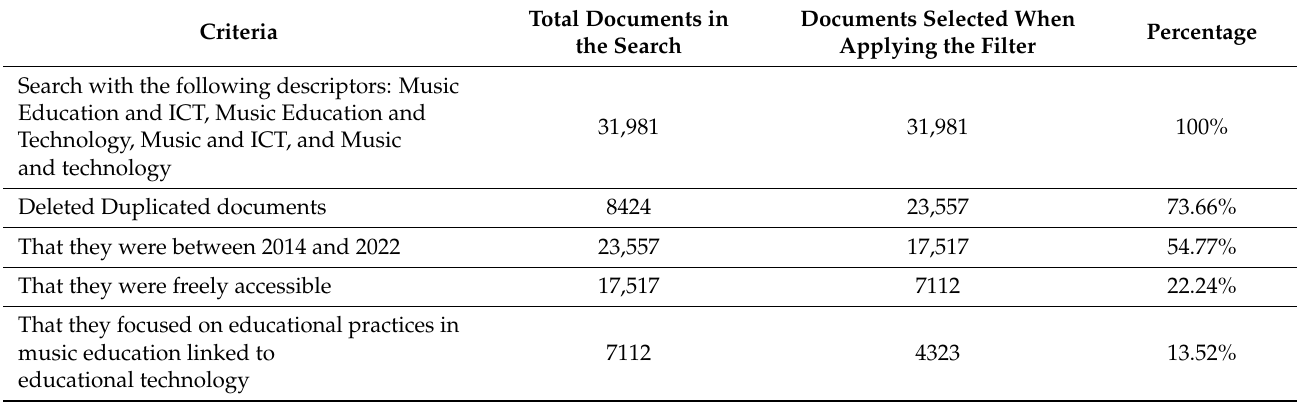
Table 2. Intermediate results of the